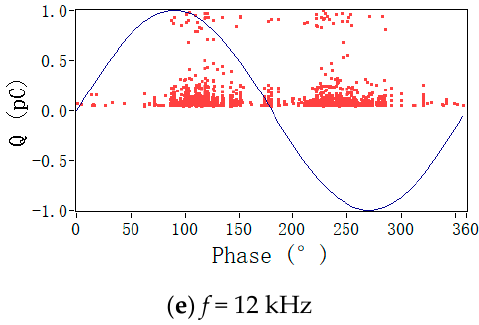
Figure 10. PD l Q ‐Φ Scatter Plot at different frequencies